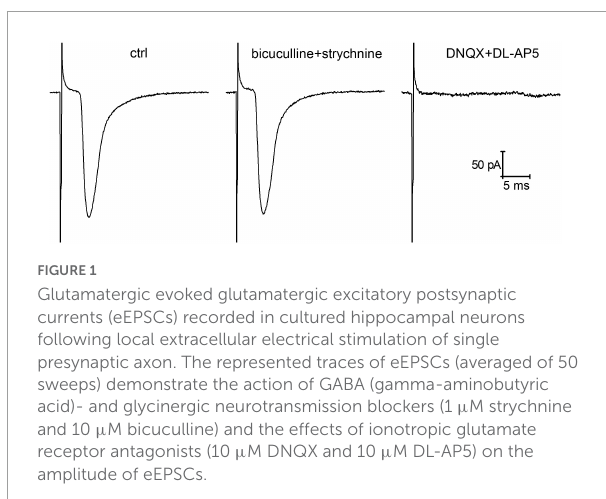
and glycinergic receptor blockers (1 µ M strychnine and 10 µ M bicuculline) did not alter the amplitude and kinetics of